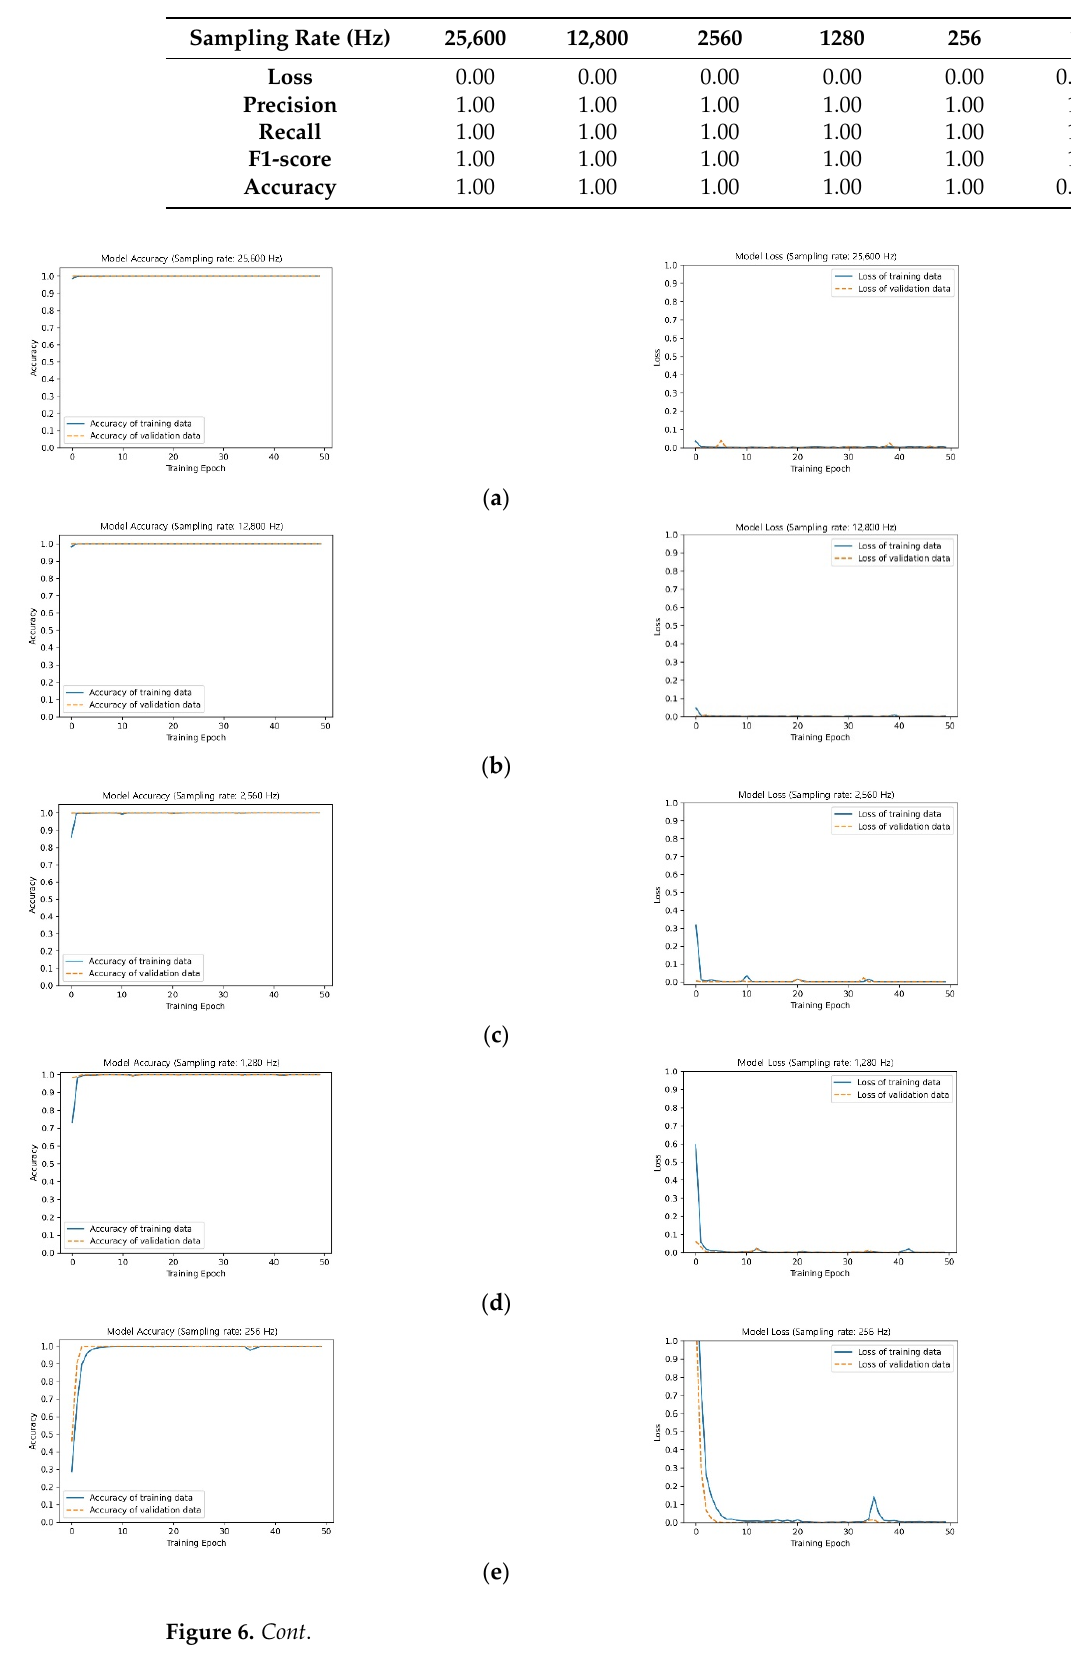
Table 8. Evaluation performance by sampling rate.